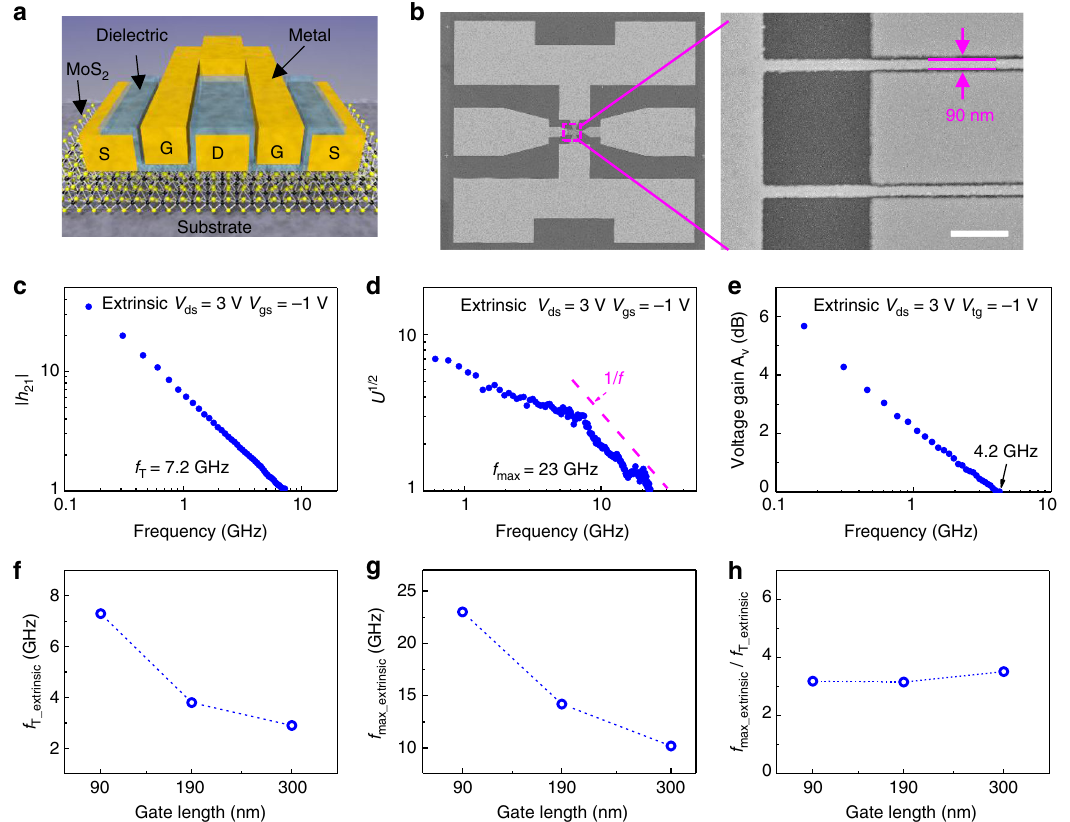
Fig. 4 High frequency measurement of short channel RF transistors. a Schematic illustration of bilayer MoS 2 RF transistor. S, source, D drain, G gate. b The SEM images of MoS 2 RF transistor with dual-channel structure show excellent alignment of gate to source and drain. Scale bar is 500 nm. c Small-signal current gain | h 21 | versus frequency for device with gate length of 90 nm. The extrinsic cut-off frequencies f T is 7.2 GHz. Where V ds = 3 V and V gs = − 1 V. d Unilateral power gain U versus frequency for device with gate length of 90 nm. The extrinsic maximum oscillation frequency f max is 23 GHz. Where V ds = 3 V and V gs = − 1 V. e Voltage gain versus frequency for device with gate length of 90 nm. Where V ds = 3 V and V gs = − 1 V. f Extrinsic f T as a function of gate length. g Extrinsic f max as a function of gate length. h f max / f T as a function of gate